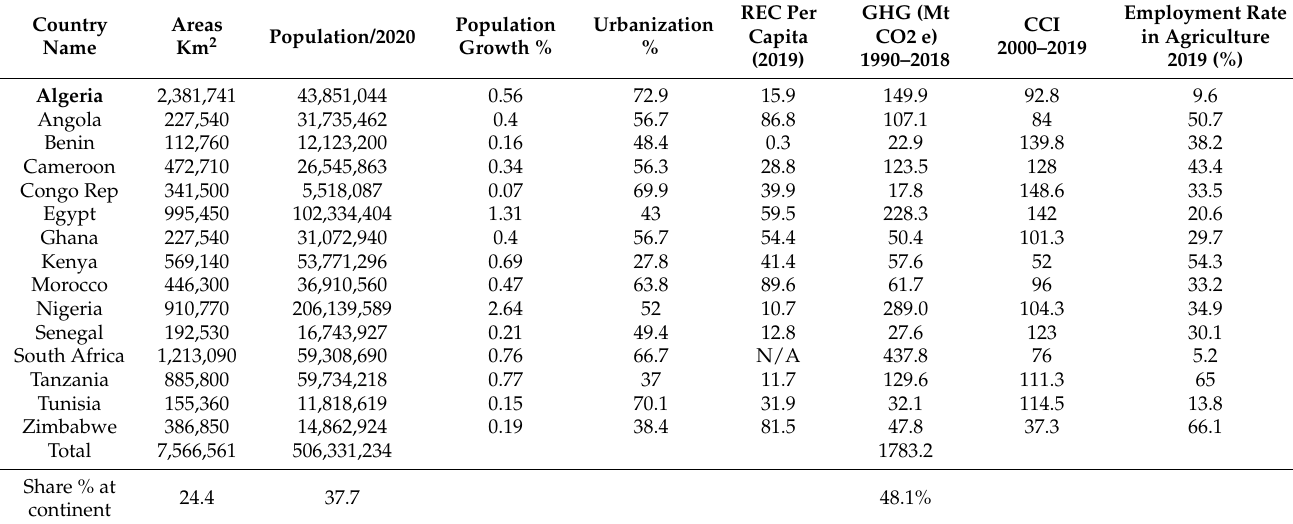
Table A1. Description of 15 selected countries in